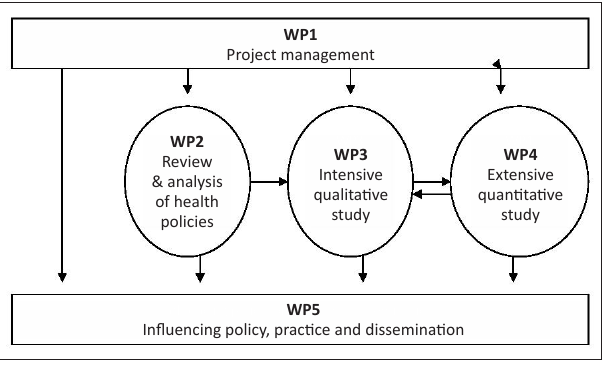
FIGURE 2: Schematic representation of the relationship between the five work packages in